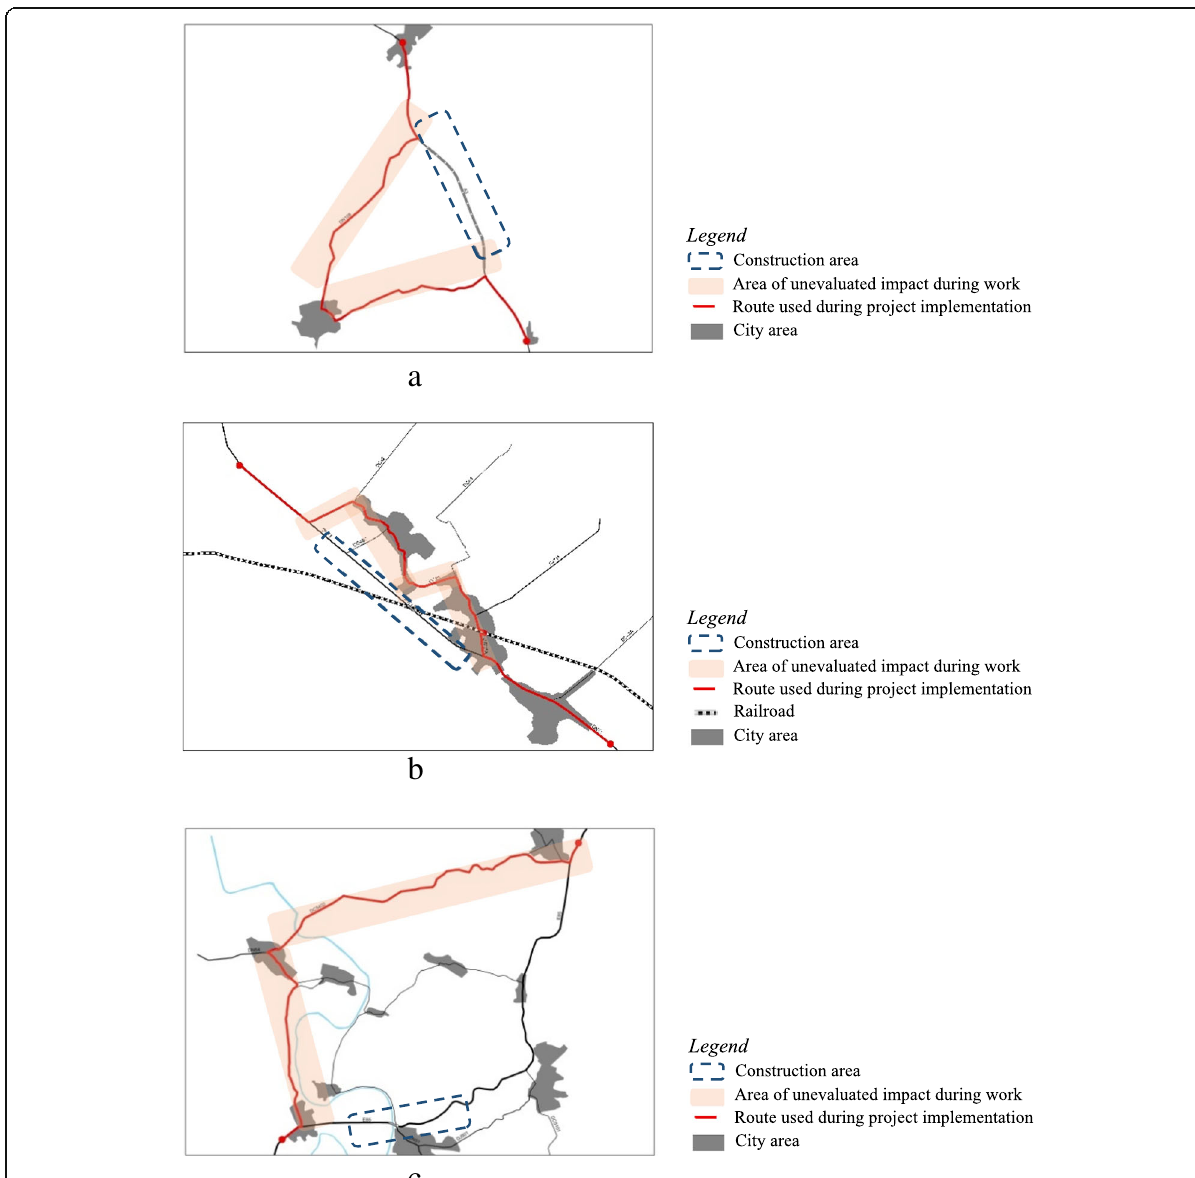
Fig. 1 Example of supplementary impact necessary to be evaluated for project in traffic infrastructure. a New road section project: traffic detour on 16 km adjacent national roads and through next city for 2 years of work; additional social costs including 11.4 mills. Euro time value and 1.15 mills. Euro emission costs. b National road upgrading project: impact during work for the road bypass on railway - heavy traffic detour on 2.5 km regional and county roads for 2 years; not comprised additional social costs including 4.6 mills. Euro time value and 0.15 mills. Euro emission costs. c National road modernization project: impact during work for a road junction upgrading - heavy traffic detoured on 15 km regional roads for 2 years; not comprised additional social costs including 15.6 mil. Euro time value and 1.18 mills. Euro emission